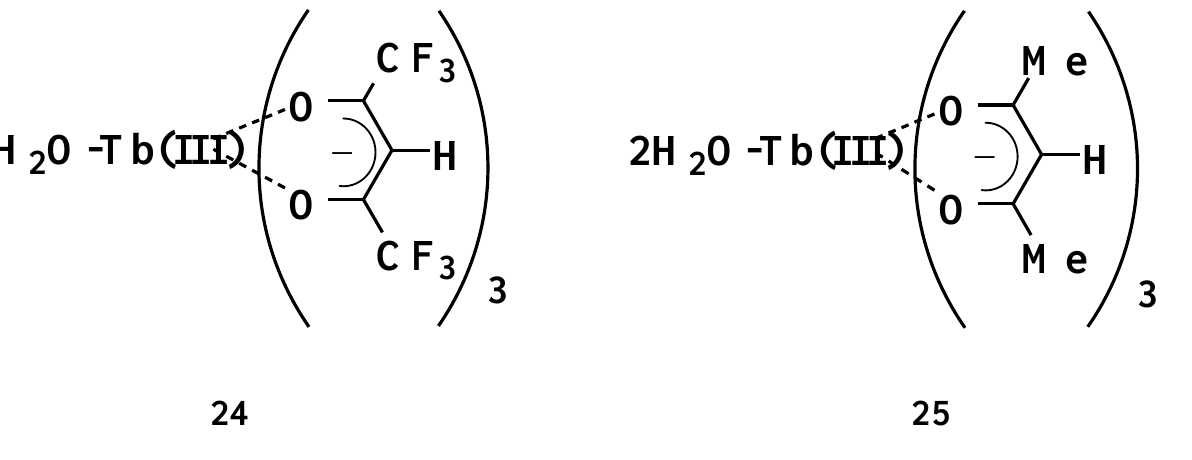
Figure 16. The emission spectra of Tb(III) complexes 19 , 20 , 21 , 24 , and 25 in ethyl acetate (normalized with respect to the transition “from 5 D the magnetic-dipole